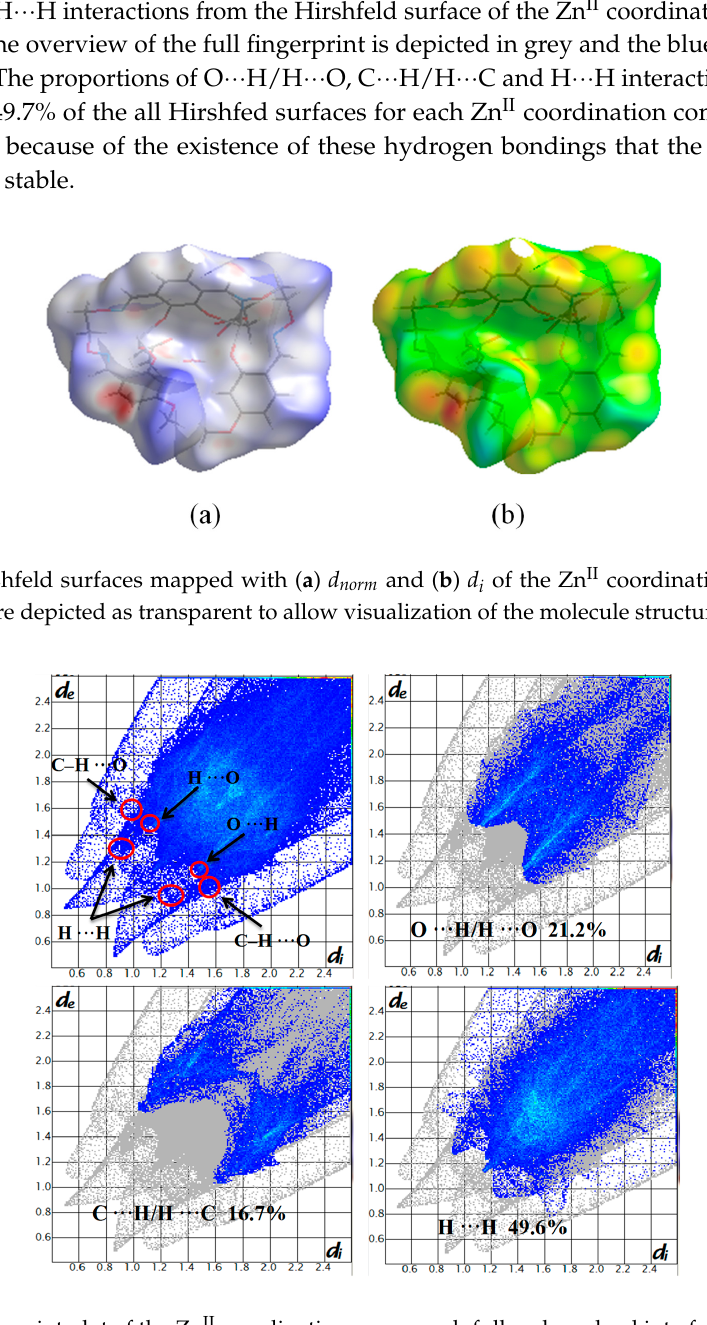
Figure 7. Fingerprint plot of the Zn II coordination compound: full and resolved into full and resolved